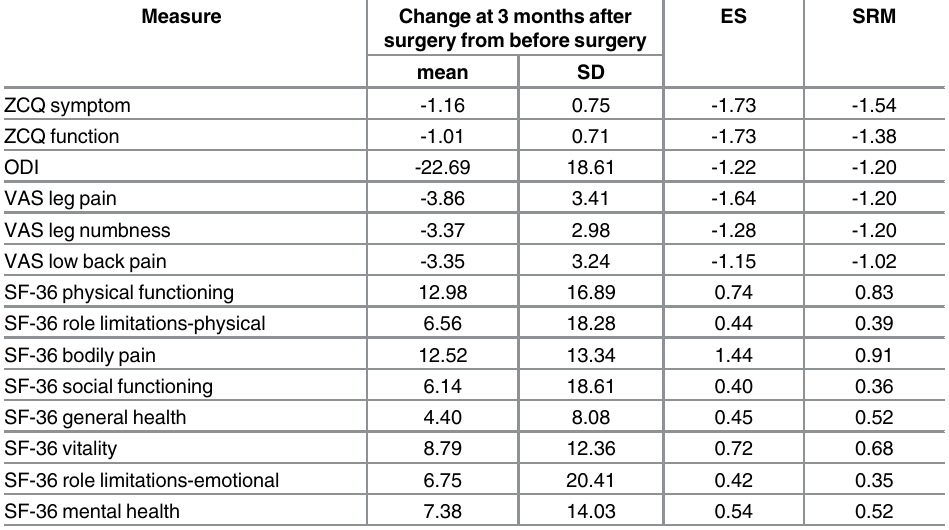
Responsiveness of the ZCQ satisfaction domain was not calculated because a response on satisfaction was not obtained prior to